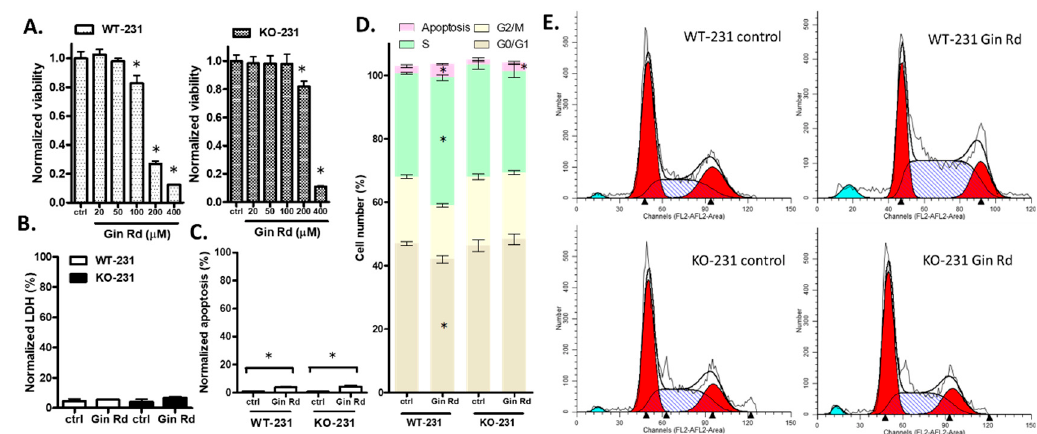
Figure 8. The e ff ect of Gin Rd on TRPM7 knockout MDA-MB-231 cell biology. ( A ) Viability. Gin Rd (100 µ M) suppressed viability in WT-231 only, while Gin Rd (200–400 µ M) significantly suppressed